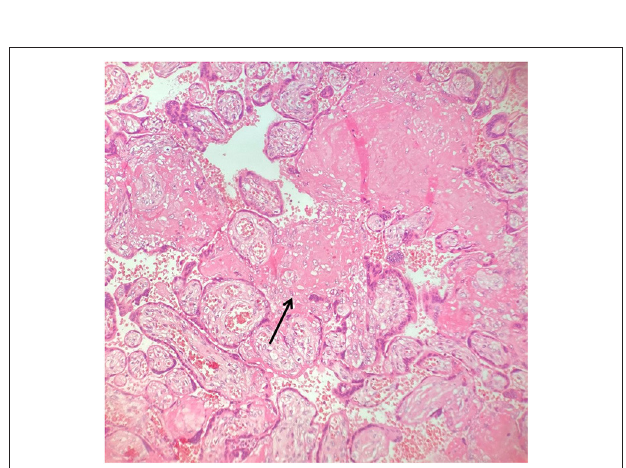
FIGURE 2 | Placental villous changes (increased syncytial knots, villous agglutination, increased intervillous fibrin deposits -